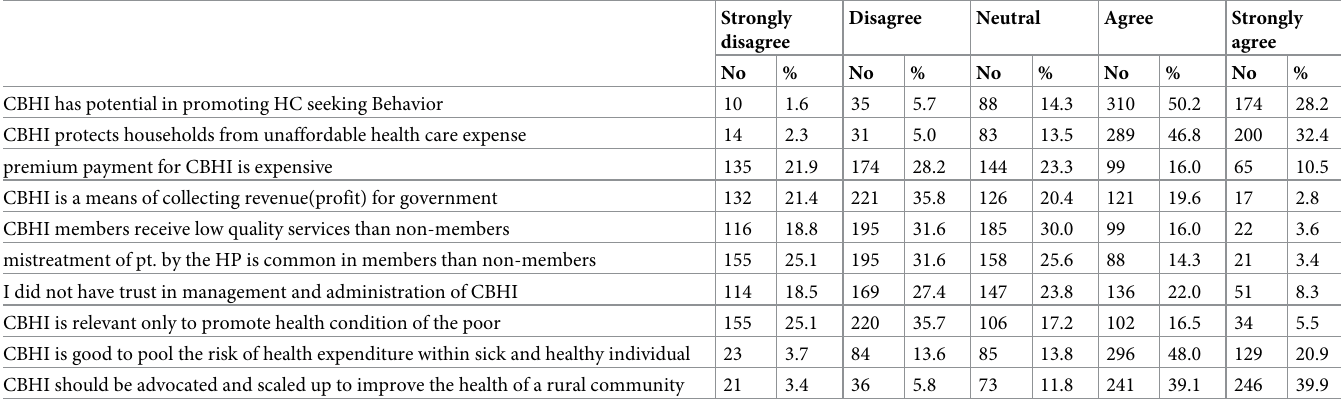
Table 2. Attitude of insured household towards CBHI scheme in Manna district, Jimma zone, southwest, Ethiopia,